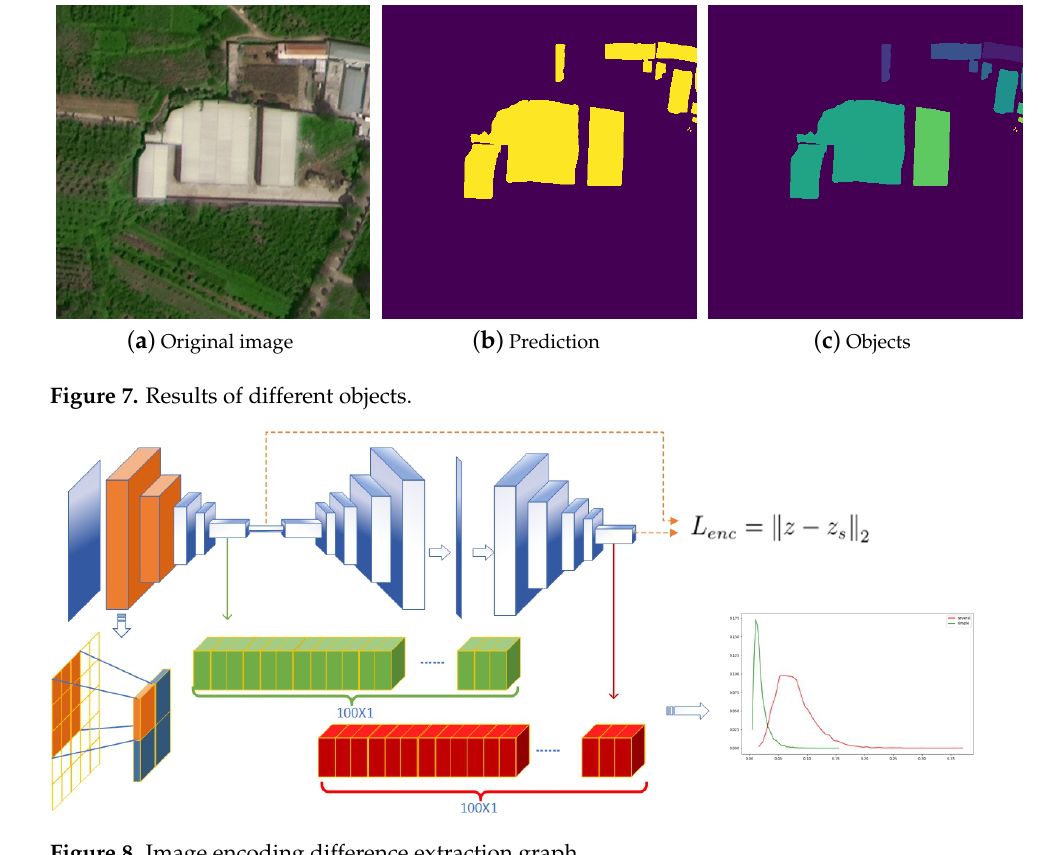
Figure 8. Image encoding difference extraction